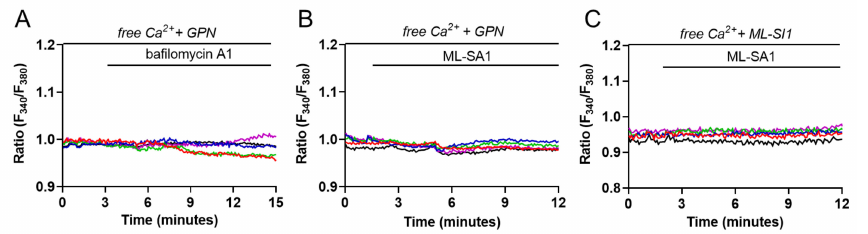
Figure 4. Lysosomal Ca 2+ responses depend on lysosomal Ca 2+ content and TRPML1 activity. ( A ) Cytosolic Ca 2+ measurements after 30 min pretreatment with 200 µ M GPN following the addition